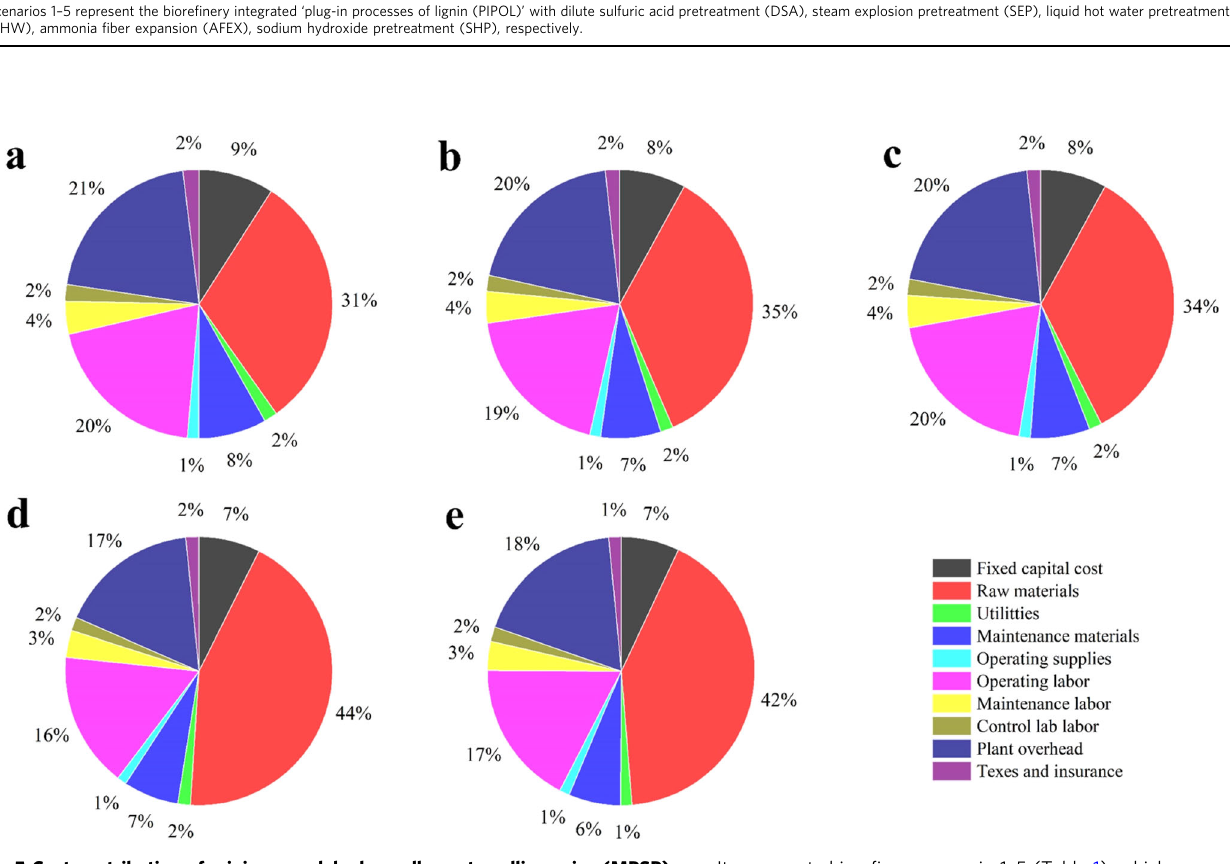
Fig. 5 Cost contribution of minimum polyhydroxyalkanoate selling price (MPSP). a – e It represents biore fi nery scenario 1 – 5 (Table 1), which was integrated “ plug-in processes of lignin (PIPOL) ’ with dilute sulfuric acid pretreatment (DSA), steam explosion pretreatment (SEP), liquid hot water pretreatment (LHW), ammonia fi ber expansion (AFEX), sodium hydroxide pretreatment (SHP),